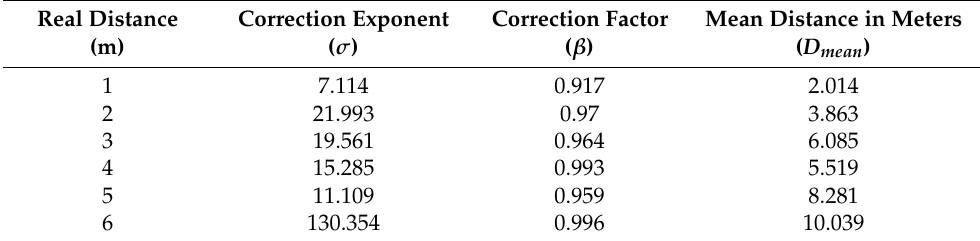
Table 2. The output factors of the RSSI distance prediction and correction model from one beacon at the office room.